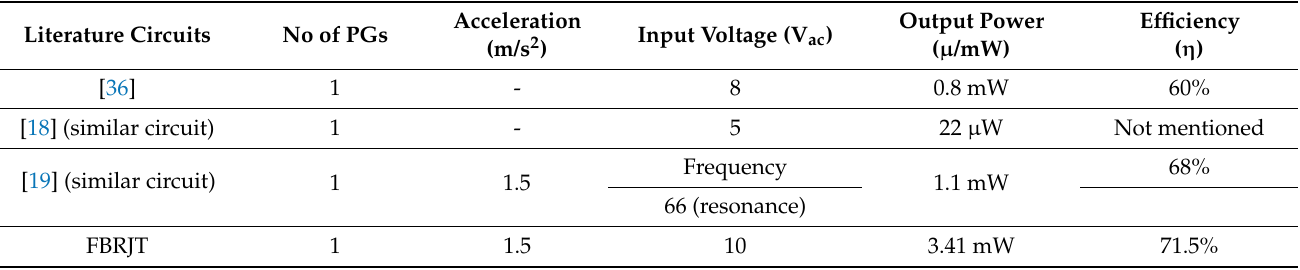
Table 3. Comparison of outcomes of circuits in the